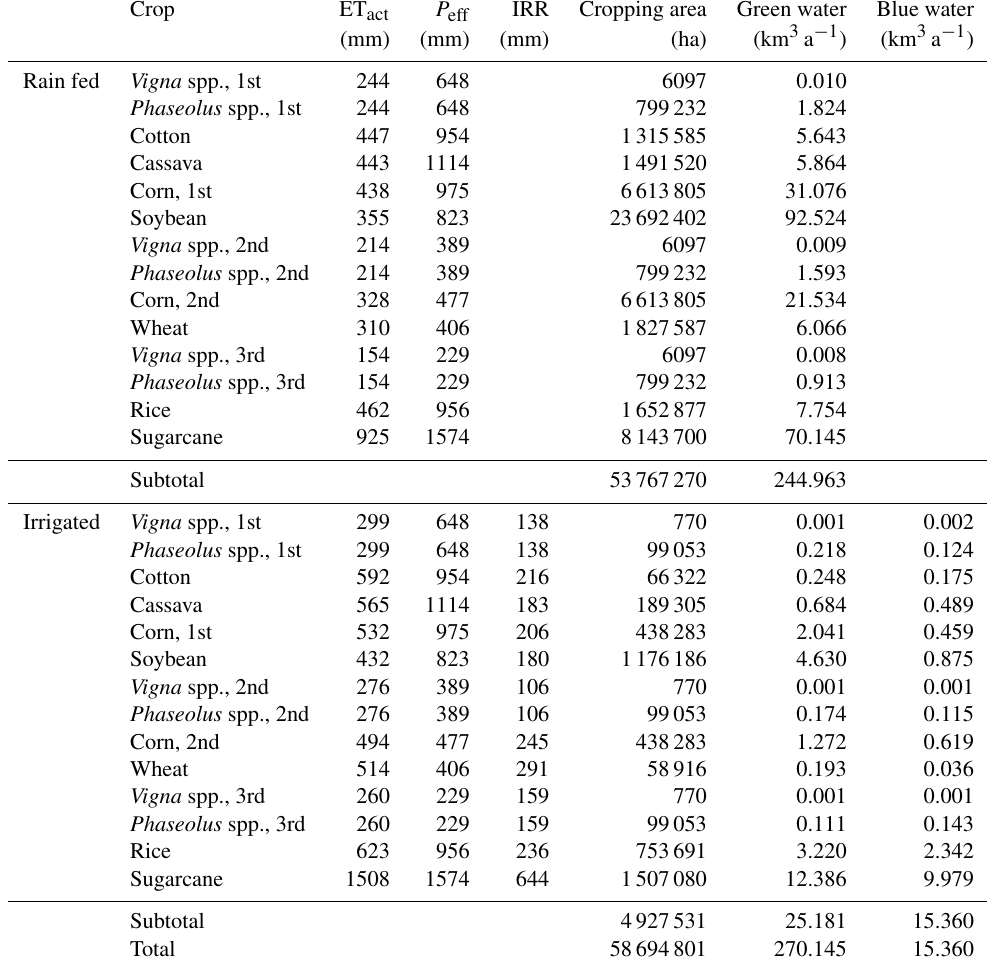
Table 2. Crop water balance and water consumption of rain-fed and irrigated crops in Brazil for the production year 2012. “1st”, “2nd” and “3rd” are the first, second and third planting dates for successive multiple cropping practices within one growing season. Crop development stages are provided in Table A1, and planting and harvesting dates are provided in Table